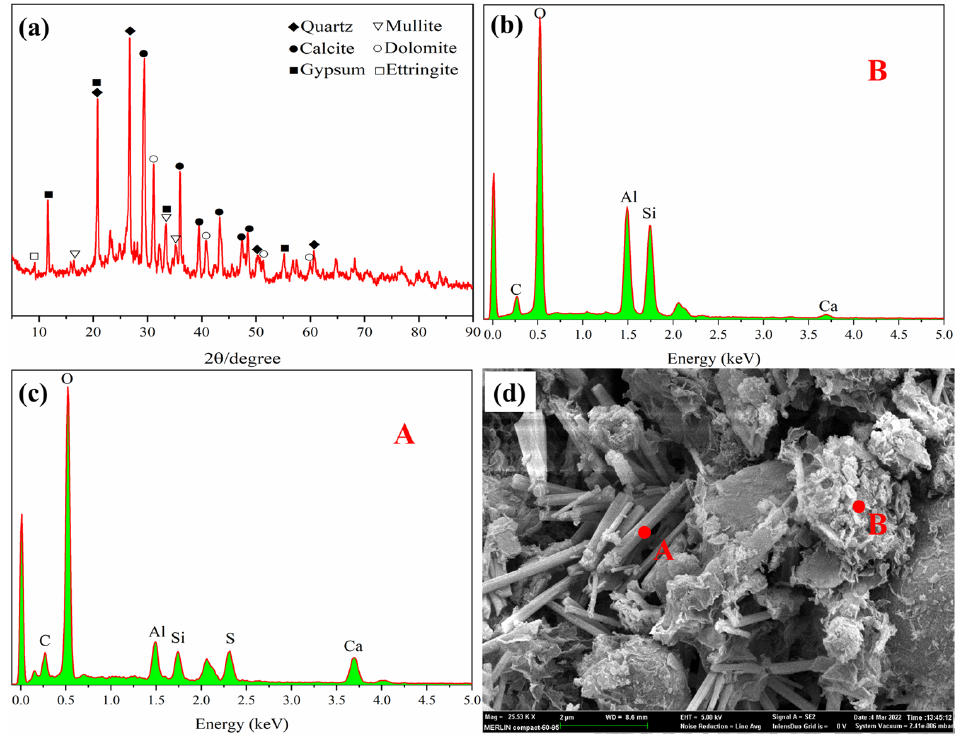
Figure 11. SEM and XRD test results. ( a ) XRD test result. ( b ) The EDS spectrum of point B in the SEM diagram. ( c ) The EDS spectrum of point A in the SEM diagram. ( d ) SEM test result.